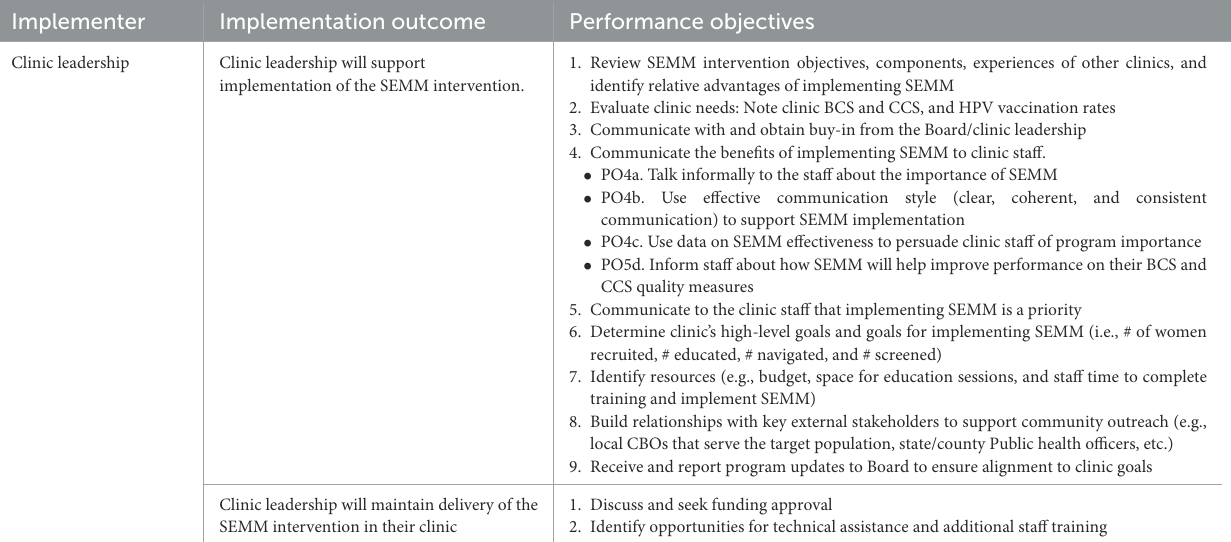
TABLE 3.1 Implementation outcomes and performance objectives: leadership level (example).